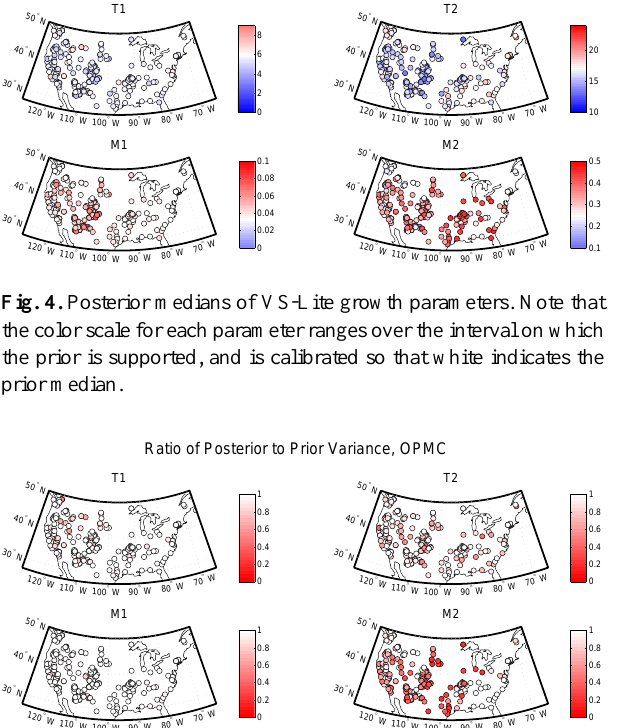
Fig. 5. Ratio of posterior to prior variance for the four growth re- sponse parameters as a measure of Bayesian learning in the ob- served proxy experiment. The color scale is calibrated so that sites with smaller (larger) values of the ratio, indicating greater (lesser) Bayesian learning, have darker (lighter)